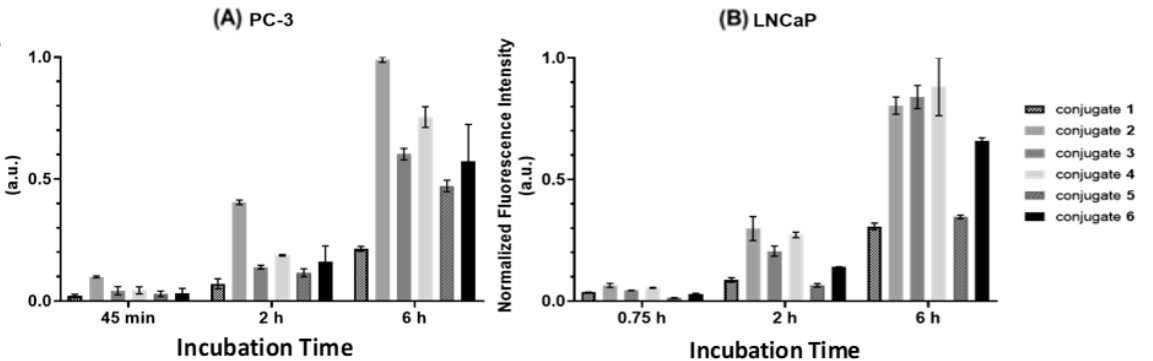
Figure 2. Normalized fluorescence intensity of PC-3 ( A ) and LNCaP ( B ) cells upon incubation with steroid-BODIPY conjugates 1 – 6 .